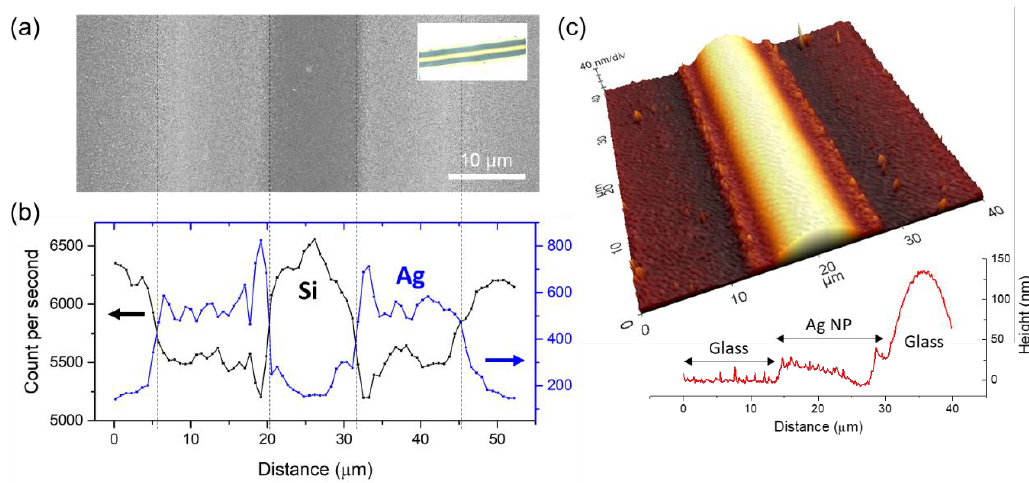
Figure 4. ( a ) Scanning Electron Microscope (SEM); ( b ) Energy Dispersive X-ray (EDX) and ( c ) Atomic Force Microscopy (AFM) measurement of the Ag NP layer which is cleaned with toluene immediately after the scanning process. The inset of ( a ) corresponds to its transmission optical microscope image. The 3D height profile in ( c ) is drawn at the scale of X : Y : Z = 1:1:30. The graph in ( c ) shows the height profile along the line perpendicular to the scanning path.